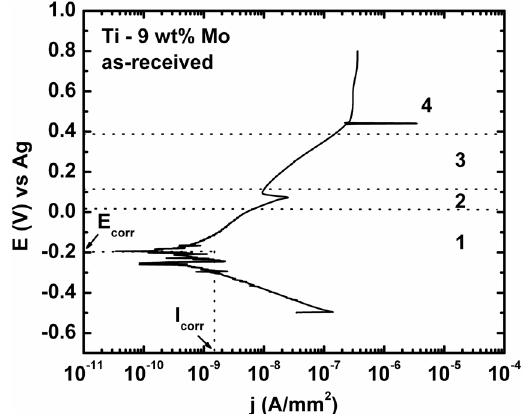
Figure 4. Potentiodynamic anodic polarization diagram of Ti-9Mo sample in as-received